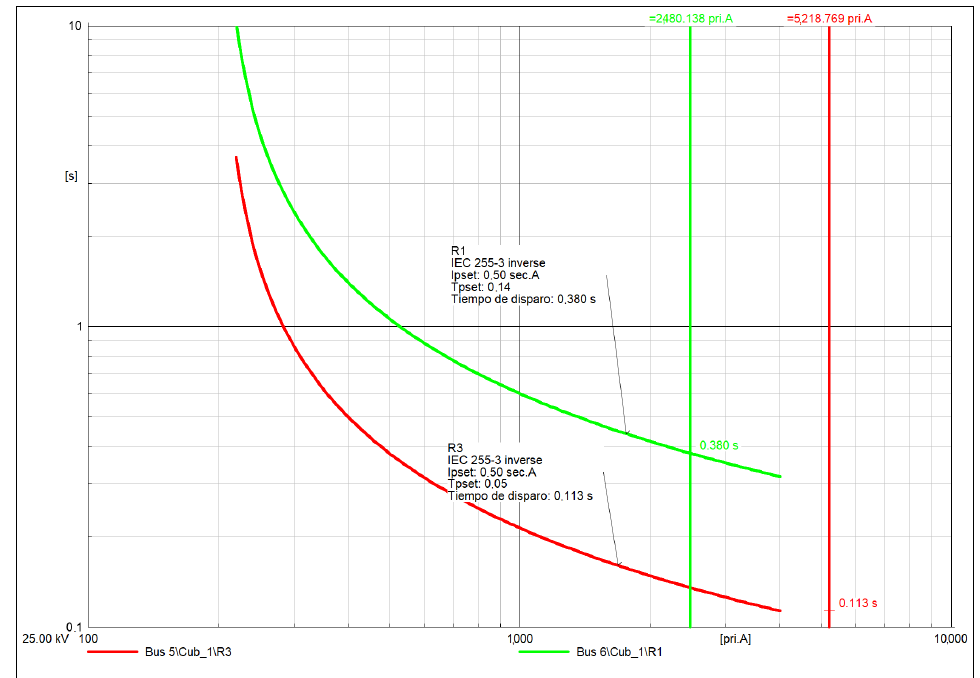
Figure 11. Coordination curve R1–R3 line fault DL-4 scenario EV2 DG.